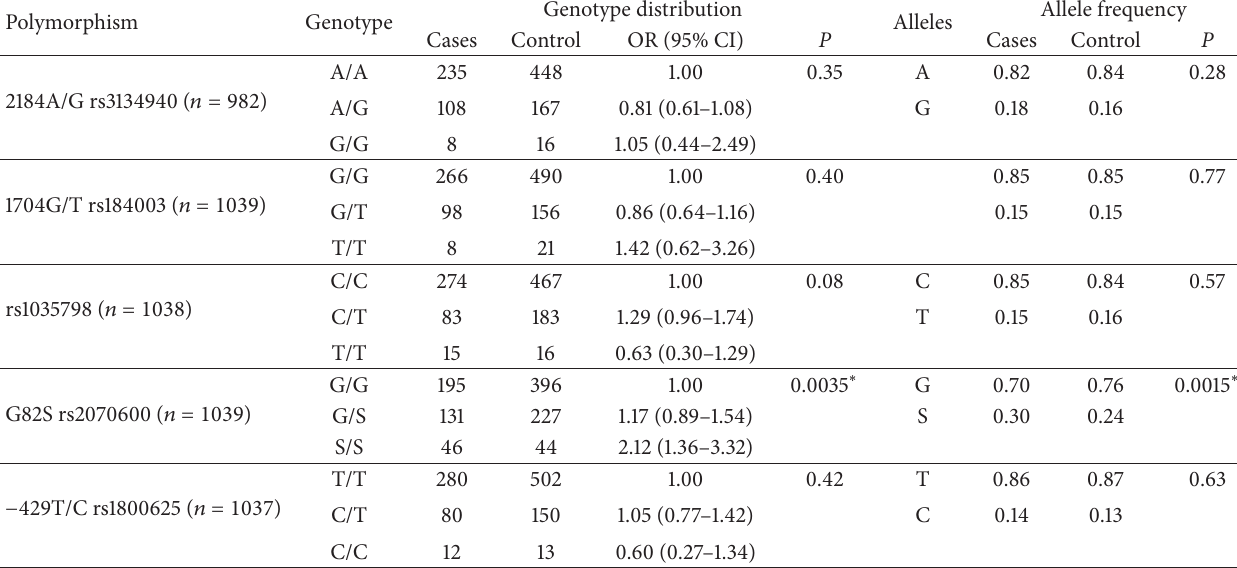
Table 2: Genotype and allele frequencies of RAGE gene polymorphisms in diabetic patients with and without retinopathy.